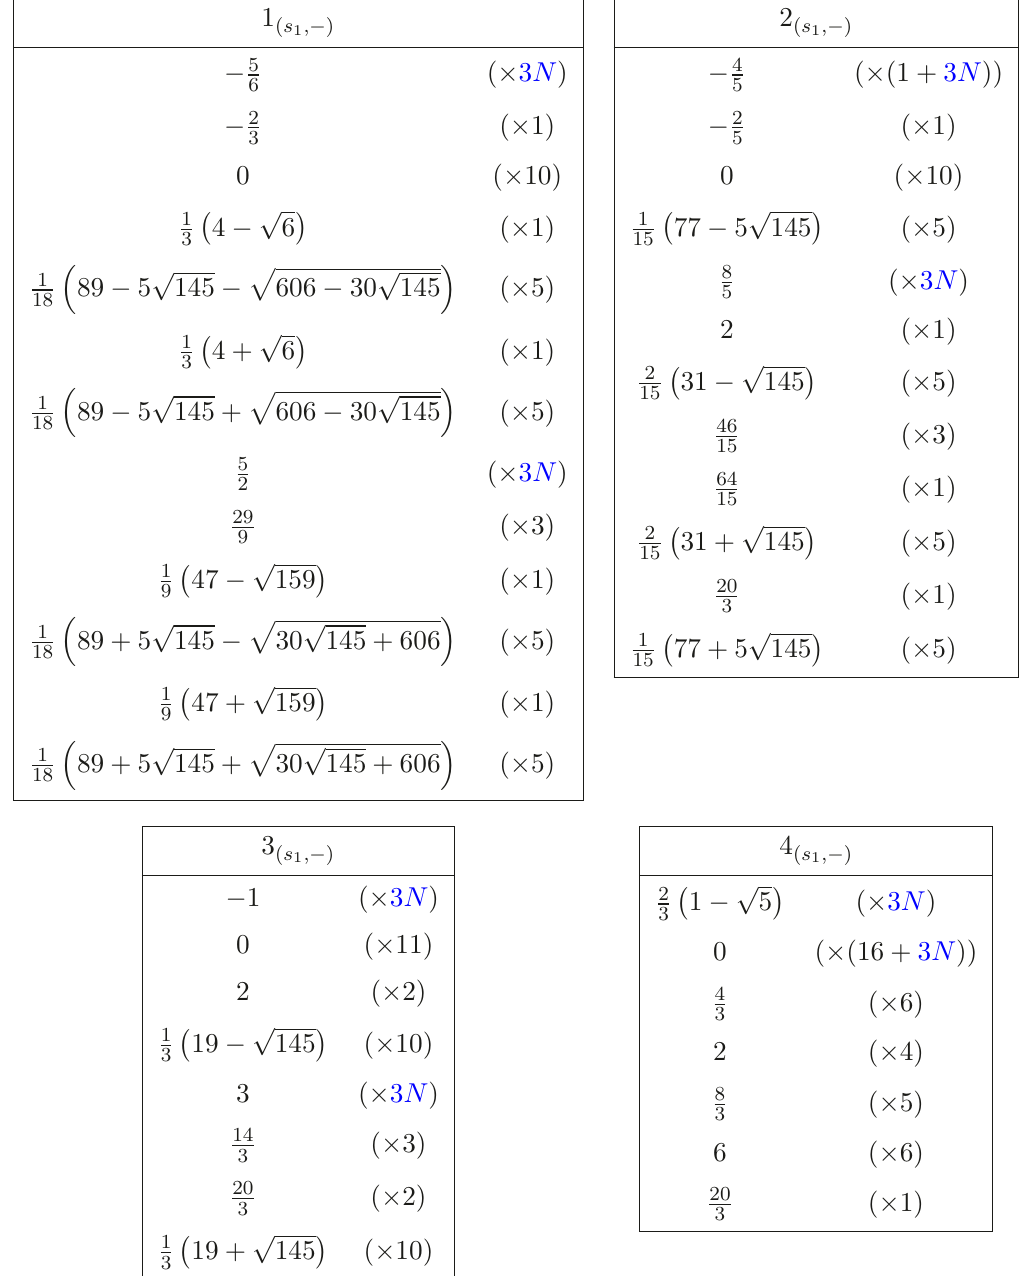
Table 8 . Normalized masses for the solutions in the extended theory with s 2 = order. The masses related to the open-string sector are shown in